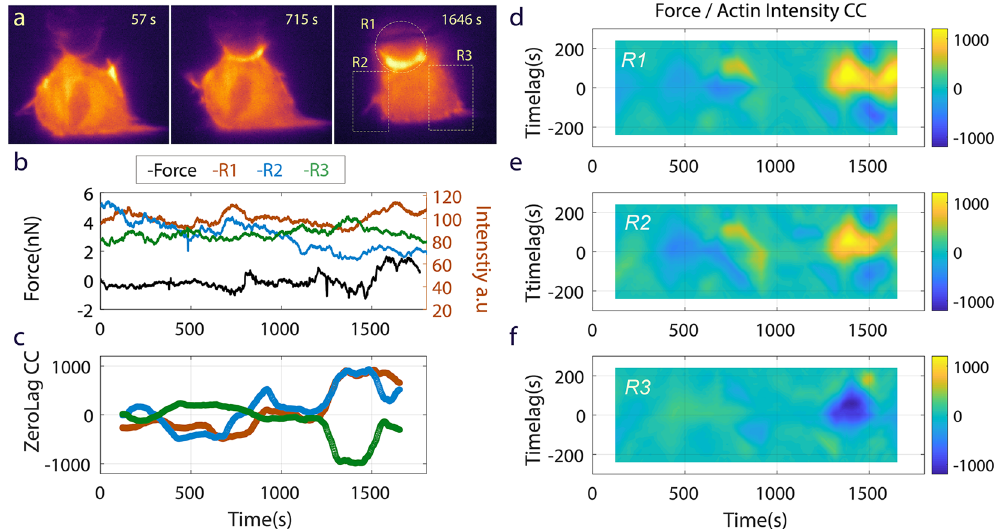
Figure 4. Correlation of Force and Actin Dynamics. ( a ) Three regions of the macrophage were selected for actin intensity analysis: region 1 (R1) , the cup, region 2 (R2) , the left edge and region 3 (R3) , right edge of cell where much ruffling and filopodia activity were present (See Supplementary Video 4). Note the regions are non-overlapping. ( b ) Raw force data and intensity data time series for the corresponding image above. ( c ) Time evolution correlation coefficient for force and intensity for each region at zero time lag. The cross correlation calculation (see text for details) was done on a 240 s window of data at increments of 2 s over the whole data set. Both force and intensity data were high pass filtered prior to cross correlation calculation to remove offset and slope (frequency cut off = 0.5 mHz). ( d–f ) show the correlation strength as a function of time lag across the whole duration of the phagocytic process for each